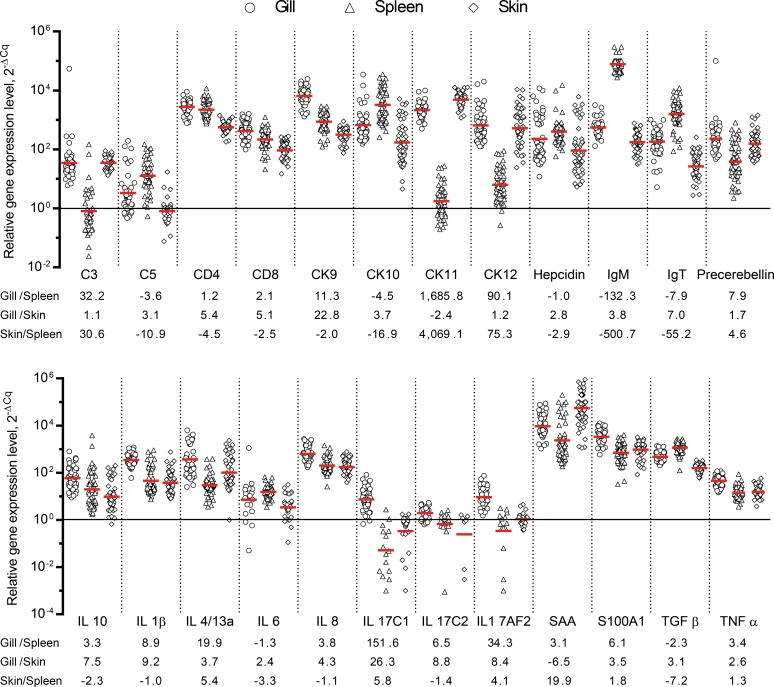
Overall expression levels of genes.The relative expression levels (both time points) were calculated as 2-ΔCq. The levels were normalized to the geometric mean of the least expressed gene (IL-17C2) (all tissues combined). All samples having valid Cq values are represented. Relative overall gene expression level (for each gene) between tissues is shown as the ratio (Gill/Spleen, Gill/Skin, Skin/Spleen).